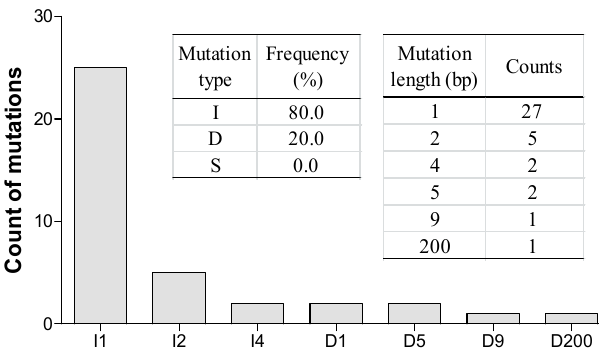
Figure 4. Mutation types and frequency in transgenic plants. Mutation types and frequency from combined data of four different targets at T 0 generation. Left insert, occurrence of insertion (I), deletion (D) and substitution (S) mutation types. Right insert, counts of different mutation length. In x-axis: I # , # of bp inserted at target site; D # , # of bp deleted from target site.